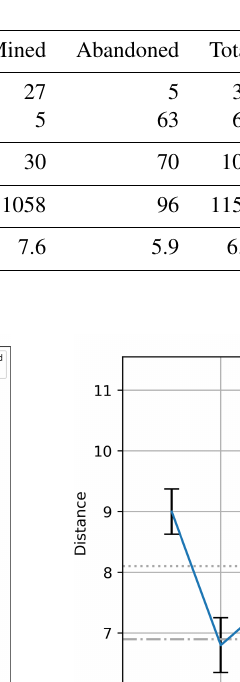
Table 3. Single-body, fixed-location POMCPOW results without action constraints.